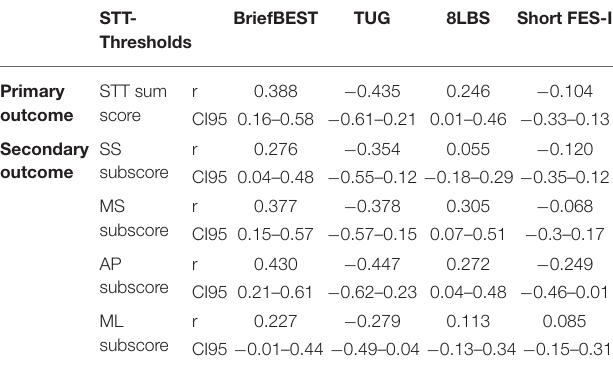
TABLE 4 | Correlation between STT sum score and subscores (DSE) and reference measures. STT-